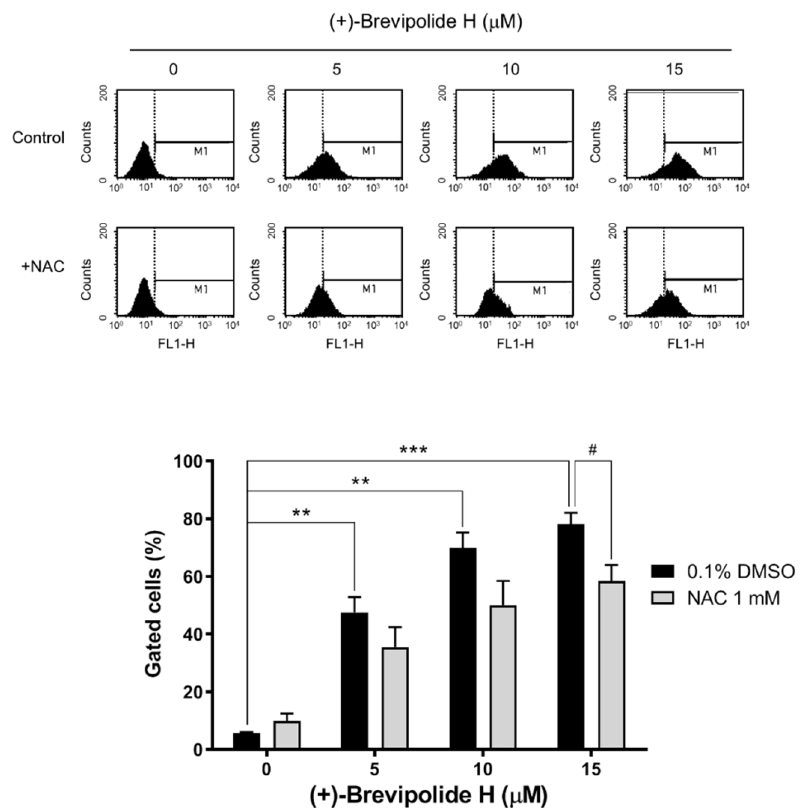
Figure 6. Effect of (+)-brevipolide H and NAC on the intracellular Ca 2+ levels in PC-3 cells. The cells were incubated in the absence or presence of (+)-brevipolide H (5 to 15 µM) and NAC (1 mM) for 1 h. Intracellular Ca 2+ levels were detected using FACScan flow cytometric analysis. Quantitative data were analyzed using BD CellQuest TM Pro Software. Data are expressed as mean ± SEM of three independent experiments; ** p < 0.01 and *** p < 0.001 compared with (+)-brevipolide H-free control and # p < 0.05 compared with respective (+)-brevipolide H group.